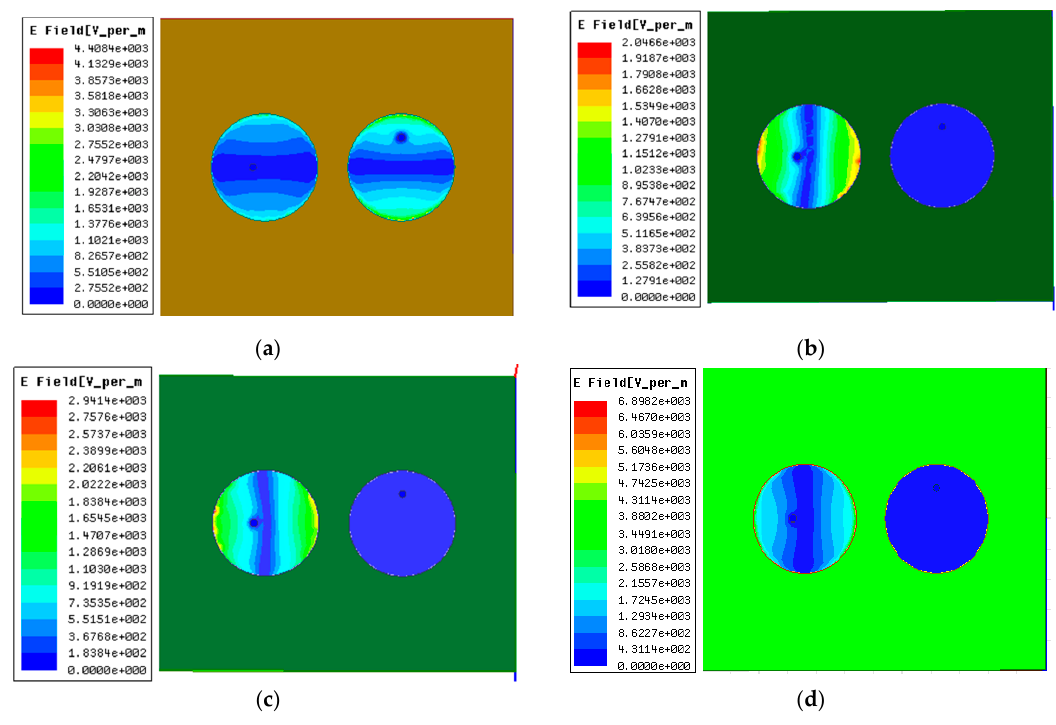
Figure 9. Surface current distribution for ( a ) Antenna-1, ( b ) Antenna-2, ( c ) Antenna-3, and ( d )